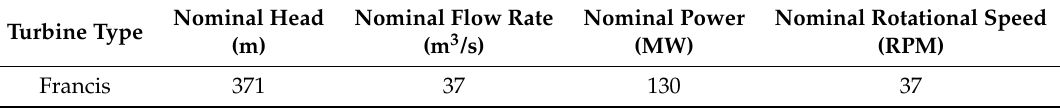
Table 2. The turbine nominal operational values; Trollheim